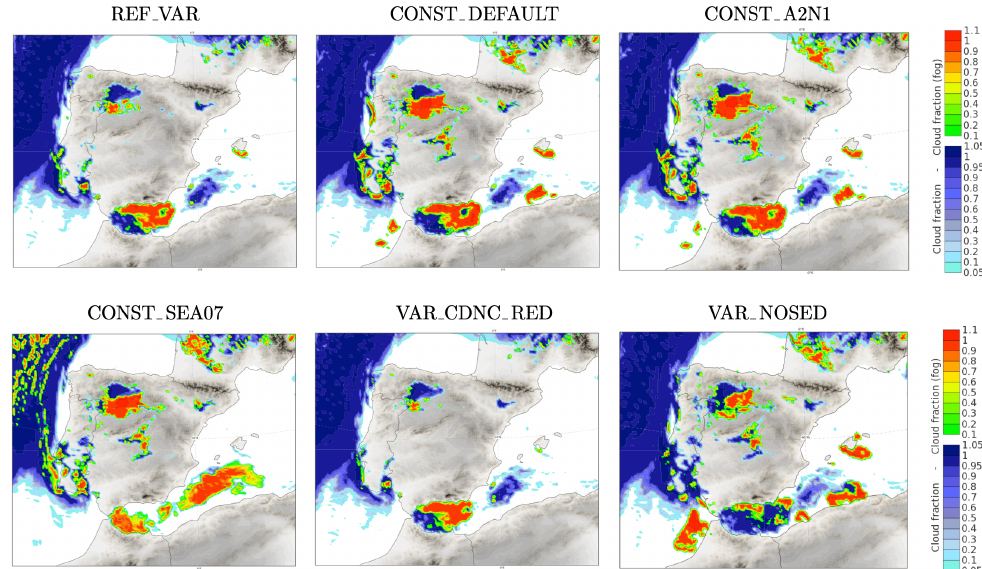
Figure 7. Iberian domain. Fraction of low clouds and fog (cloud fraction at the lowest model level), +023 h (30 December 2021 at 11 UTC). The two colour bars to the right side of the panels correspond to fog (upper colour bar; from green to red) and low clouds (lower colour bar; from cyan to dark